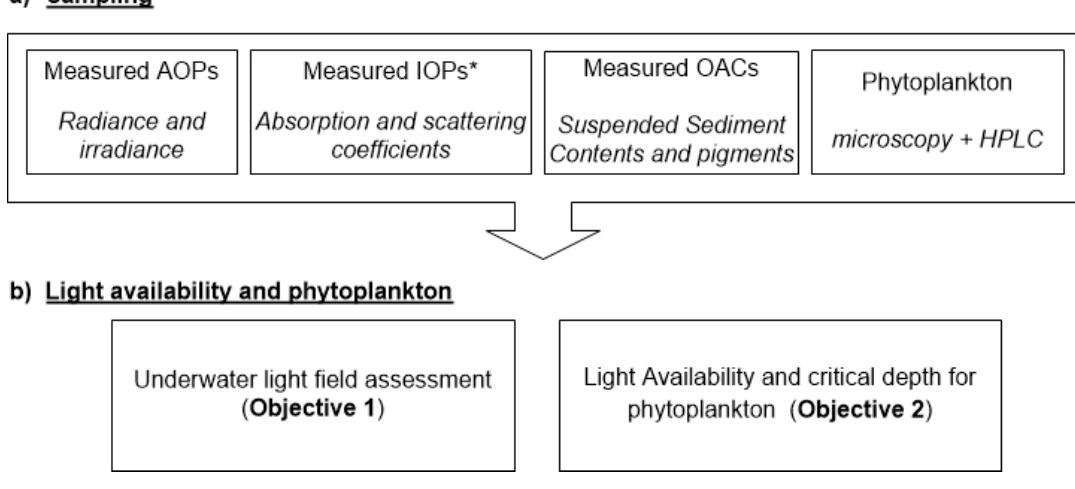
Figure 2. The methodology comprises ( a ) field campaigns for acquisition of optical properties and biogeochemical measurements to quantify underwater light field changes from non-impacted to impacted rivers; ( b ) assessment of light availability for phytoplankton, including critical depth analyses.